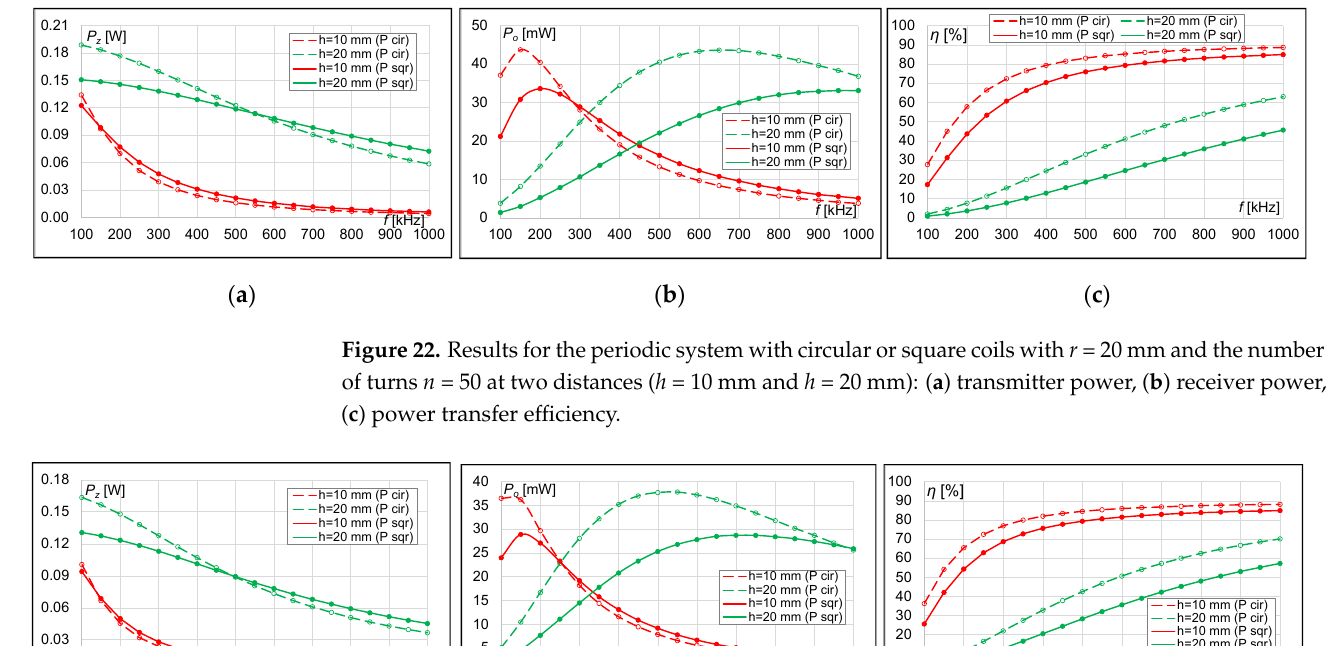
Figure 21. Results for the periodic system with circular or square coils with r = 20 mm and the num- ber of turns n = 40 at two distances ( h = 10 mm and h = 20 mm): ( a ) transmitter power, ( b ) receiver power, ( c ) power transfer efficiency.